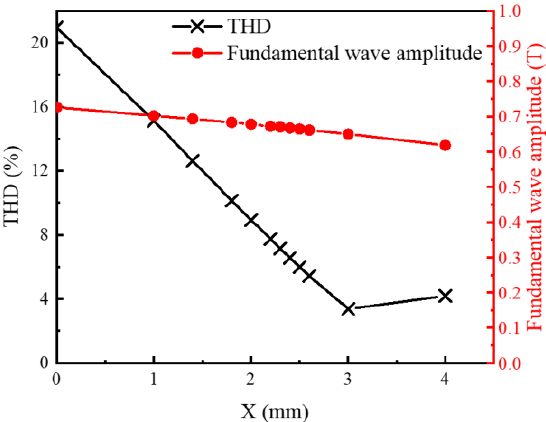
Figure 4. Relationship between THD and fundamental wave amplitude of Air−gap flux density and eccentricity.